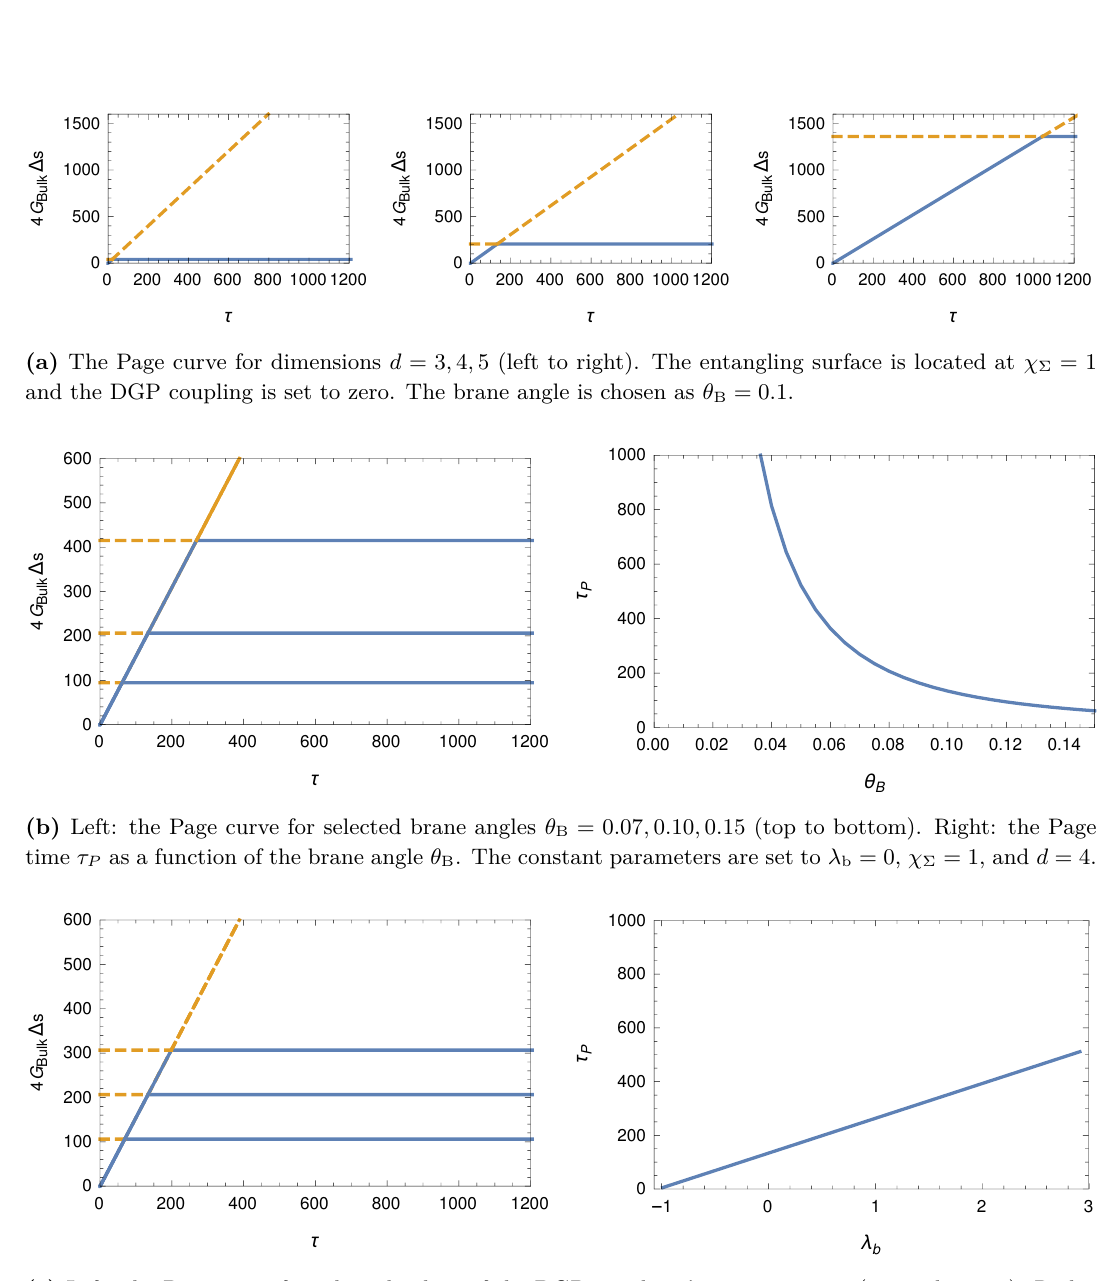
(c) Left: the Page curve for selected values of the DGP coupling λ b = 0 . 5 , 0 , − 0 . 5 (top to bottom). Right: the Page time τ P as a function of the DGP coupling λ b . The constant parameters are set to θ B = 0 . 1 , χ Σ = 1 , and d = 4 . Figure 16. The Page curve in various dimensions. The solid blue line indicates the physical Page curve. The dashed orange lines correspond to entropies calculated by non-minimal extremal surfaces. At early times, the RT surface in the no-island phase is the minimal surface. After some time, the minimal surface transitions to the RT surface in the island